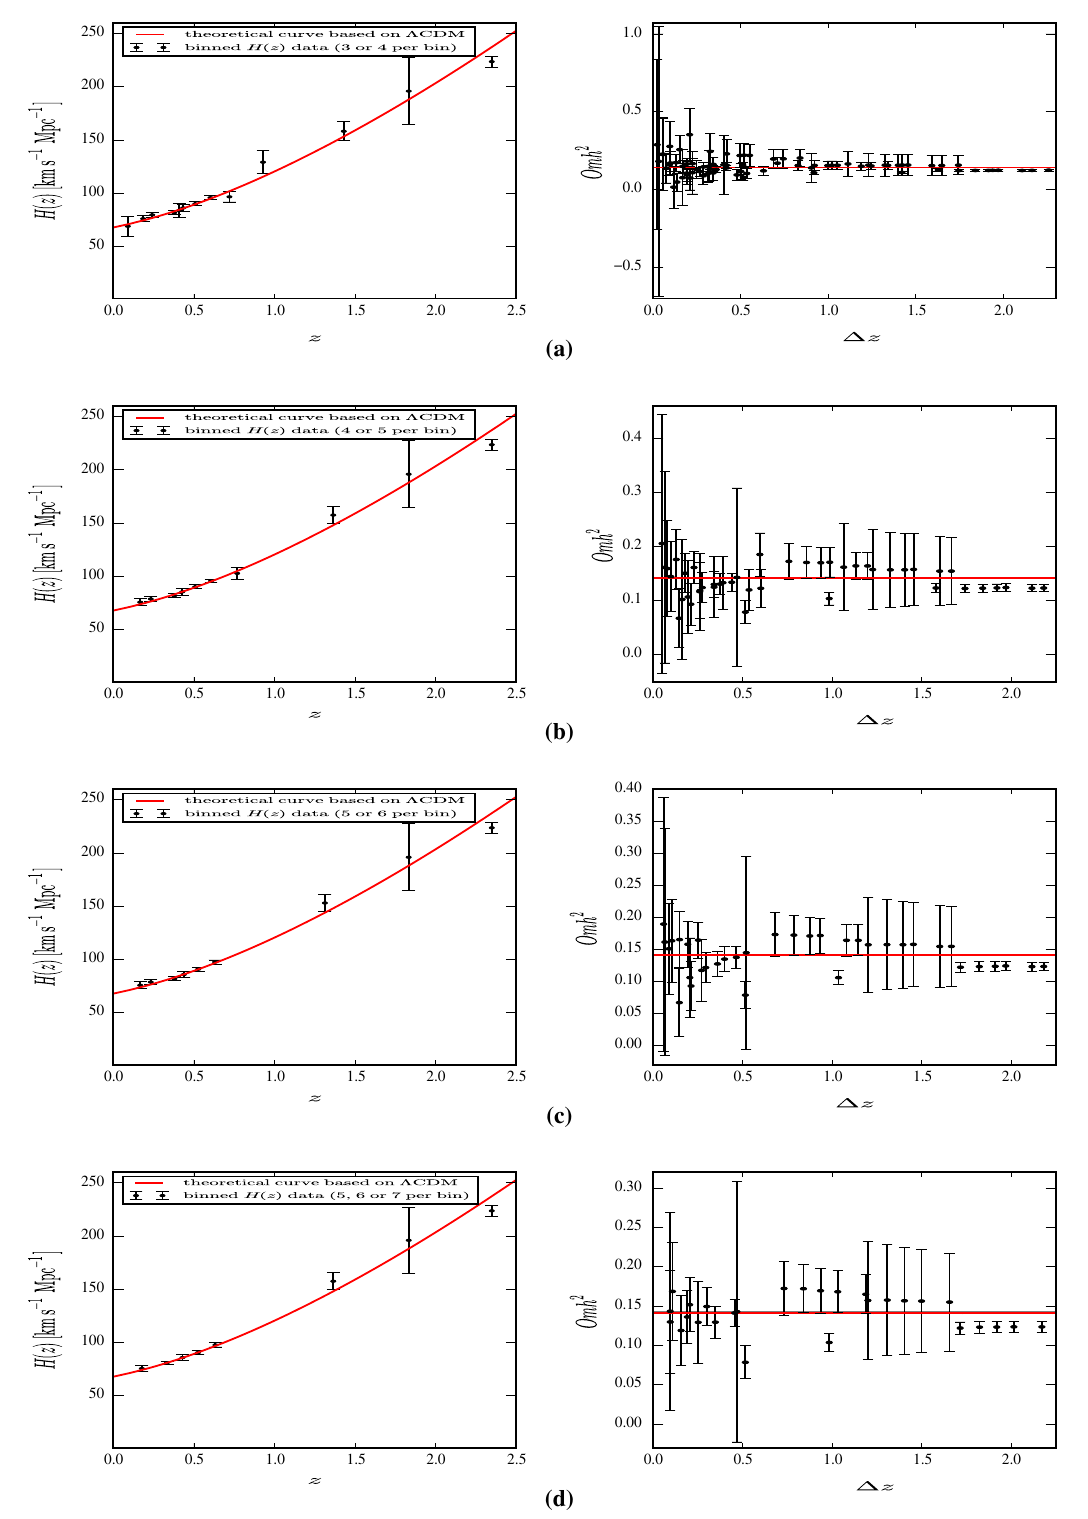
Fig. 2 Binned H ( z ) data based on full OHD and its corresponding Omh 2 diagnostic values for the weighted mean technique. The pan-